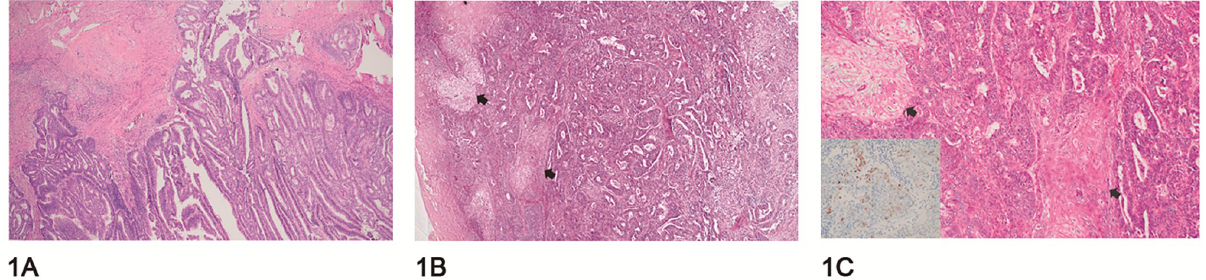
Fig 1. Histopathological difference between endometrioid adenocarcinoma with and without squamous transformation. (A) Depicts an endometrioid adenocarcinoma without squamous transformation. (B) Shows a case with squamous transformation areas highlighted with arrows. (C) Highlights the squamous transformation areas at a higher magnification (arrows). The inset presents nuclear p63 positivity, a protein antibody used to demonstrate squamous differentiation by immunohistochemistry in a squamous transformation area.